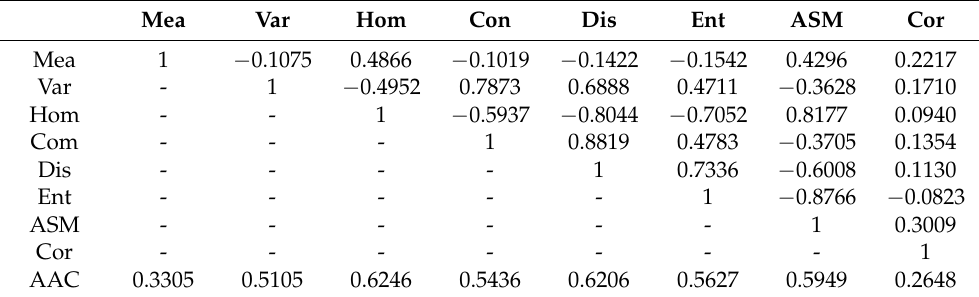
Table 7. Correlation matrix for eight texture components in the Baffin Bay data set.